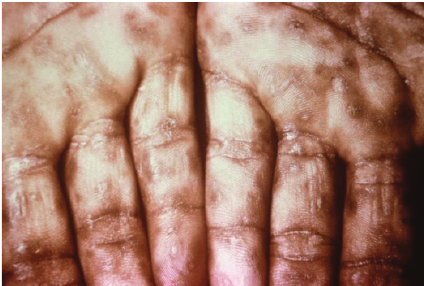
Figure 1: An example of secondary syphilis provided by the CDC: a close-up view demonstrating keratotic lesions on the